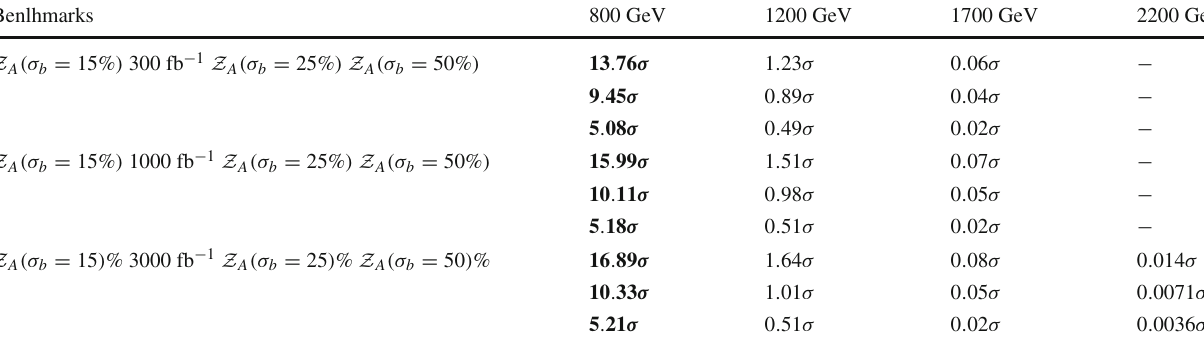
Table 3 The statistical significance for different values of the system- atics considered in this work, for various masses of the VLQ and differ- ent collider luminosities. Scenarios which pass the 5 σ requirement for